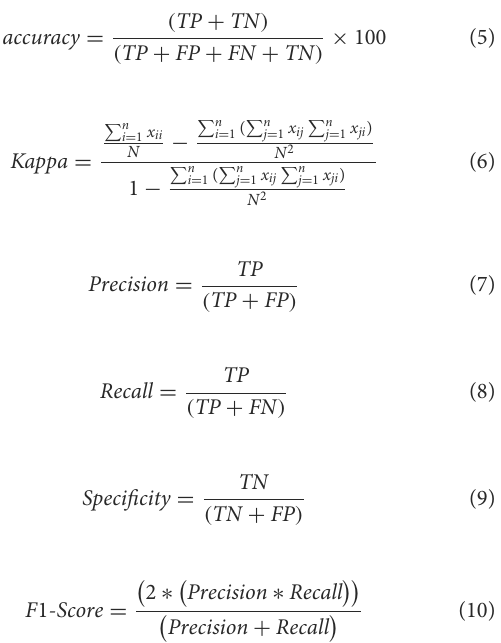
used are accuracy (Equation 5), kappa coefficient (Equation 6; Cohen, 1960), precision (Equation 7), recall (Equation 8), specificity (Equation 9), and F1 Score (Equation 10) (Labatut and Cherifi, 2012; Giraudo et al., 2018; Alamprese et al., 2021; Chen et al., 2022a; Saranya et al., 2022) in this